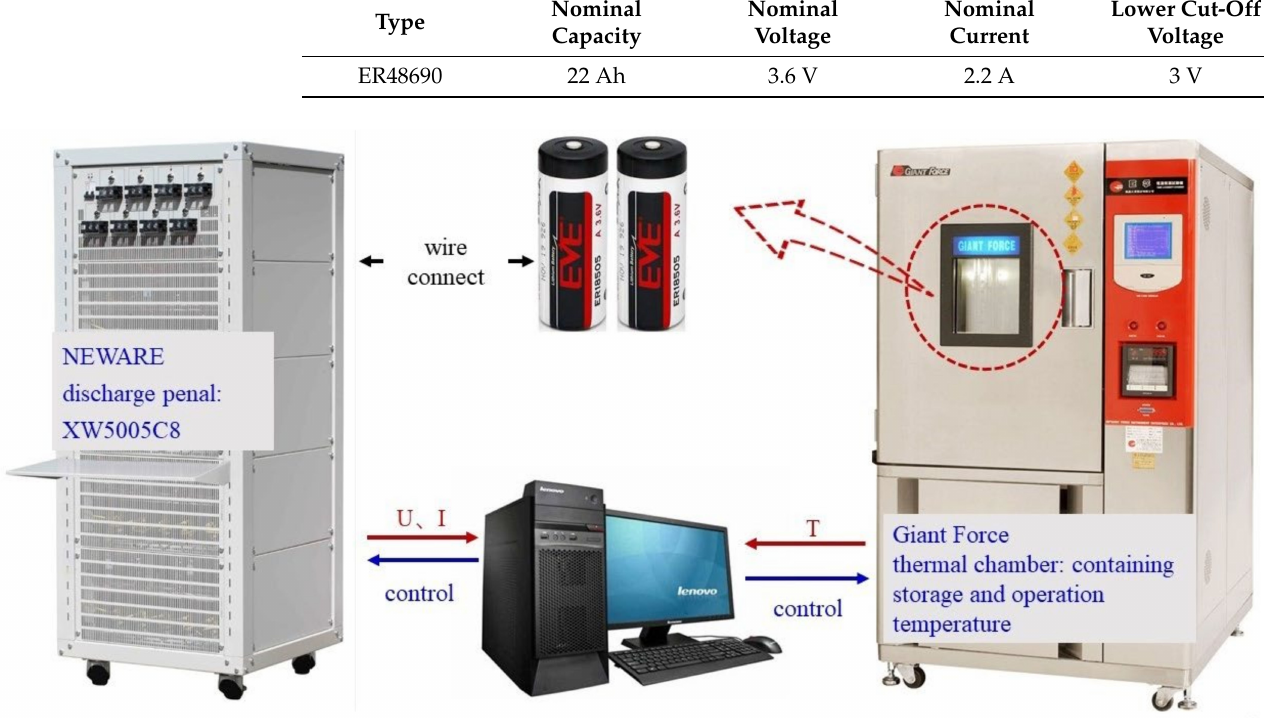
Figure 1. The test platform with a ( left ) NEWARE discharge penal and ( right ) Giant Force ther- mal chamber.